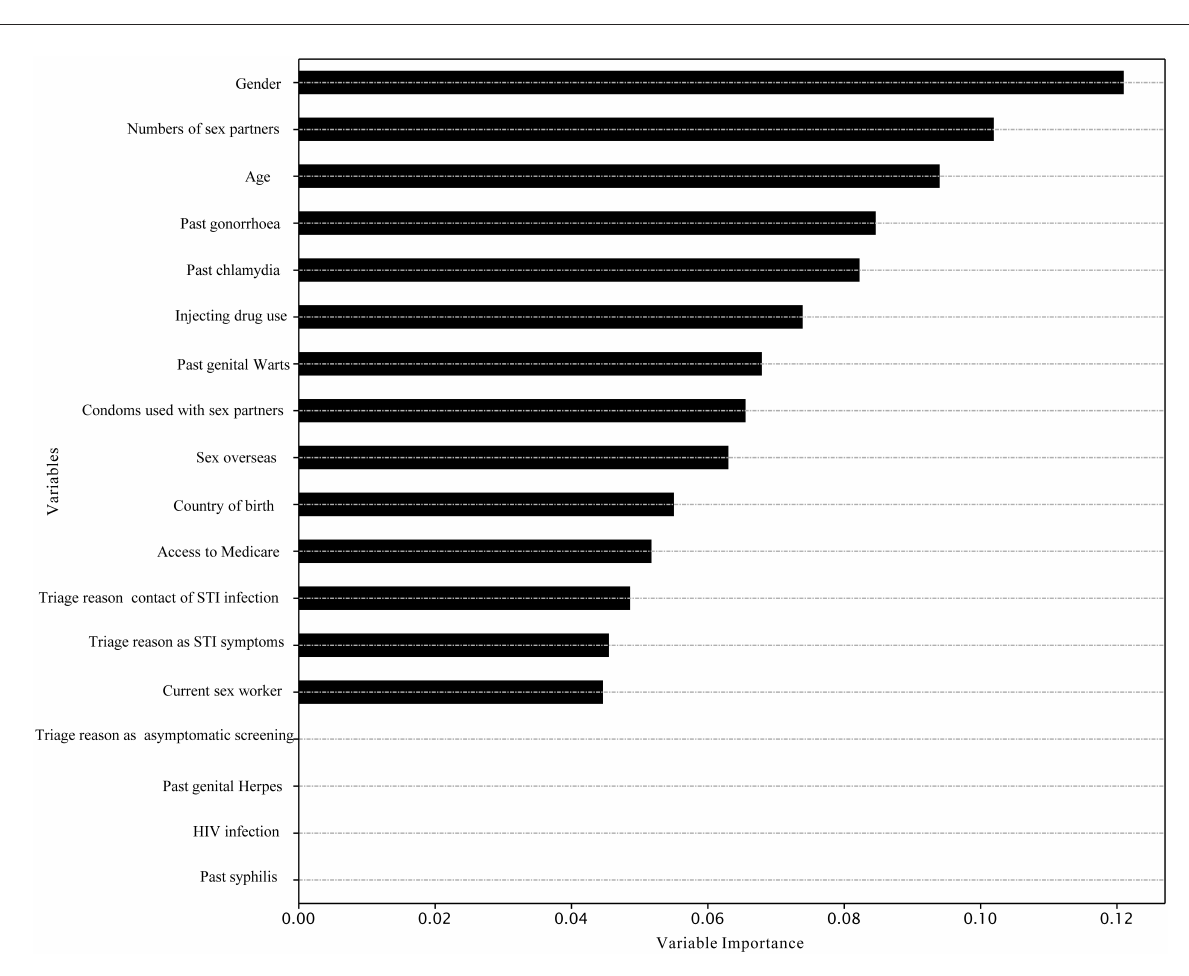
with a female or male partner (42), and sex workers (40) were among the important predictors included in the machine learning